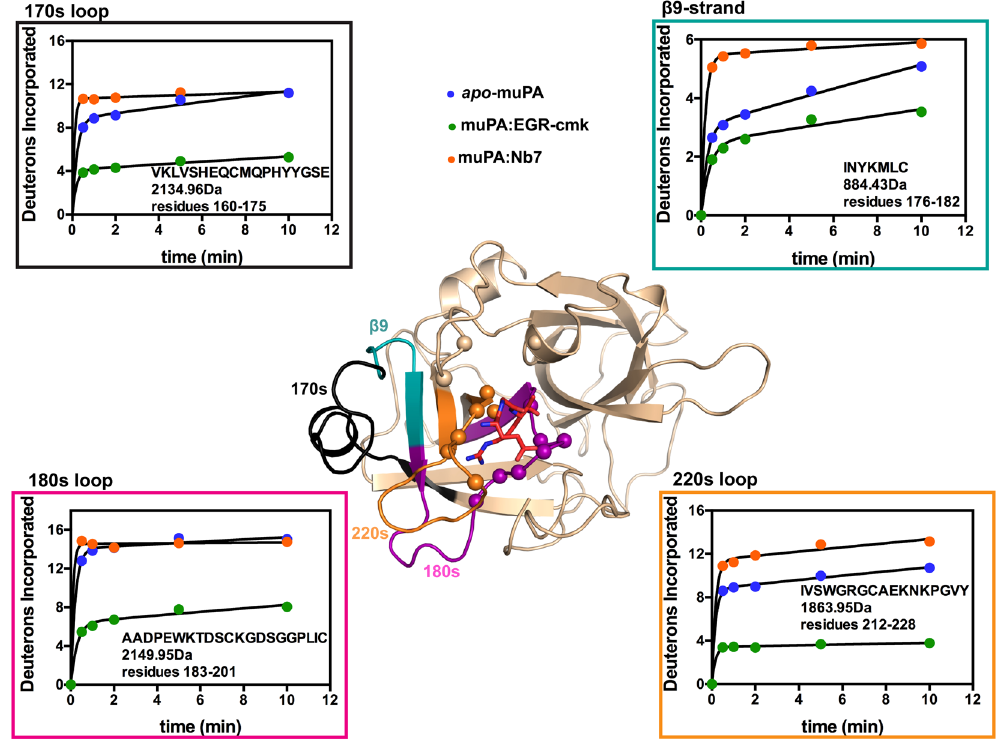
Figure 7. Backbone dynamics of muPA. Displayed is the catalytic protease domain of muPA from the muPA:Nb7:EGR-cmk structure (Nb7 is removed for clarity) with EGR-cmk shown as sticks (red). Residues in muPA within contacts distance of EGR-cmk ( < 4 Å) are represented as spheres. Peptides included in the HDXMS analysis and their corresponding deuterium uptake plots are highlighted on the structure and boxed in different colors: 170s loop (black); β 9-strand (teal); 180s loop (magenta); 220s loop (orange). The deuterium uptake plots show the 4 peptides from apo -muPA (blue), EGR-cmk-bound muPA (green) and Nb7-bound muPA (orange) respectively. The amino acid sequence and molecular masses are indicated for each peptide. The Y-axis is scaled to show the maximum uptake for each individual peptide. Error bars, s.d. (n = 3 independent